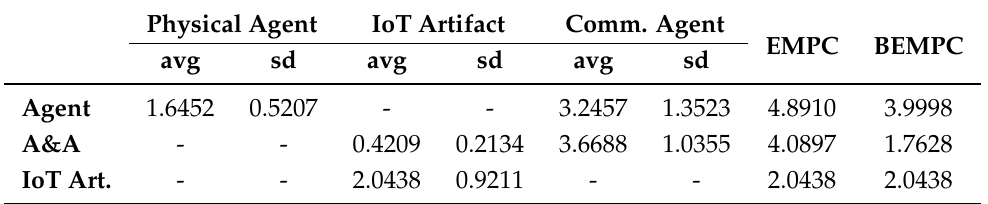
Table 2. Performance tests’ results of the engineering approaches after 200 messages sent.